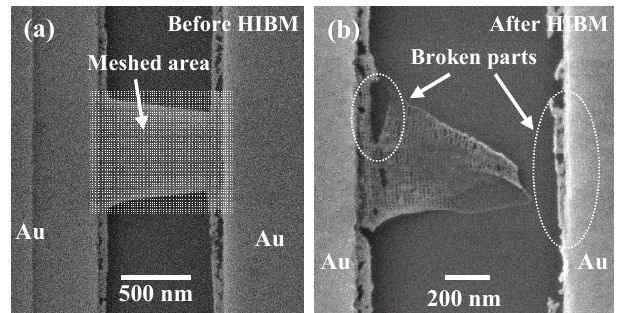
Figure 4. ( a ) The image shows the suspended graphene device before HIBM. The white dots square matrix is the area where the helium ion beam will drill the nanopores on, which covers all the suspended graphene area. ( b ) The image shows that the suspended graphene fell down after HIBM on the device in (a). The collapse happened in the connection part between the metal and graphene, shown as “Broken parts” in the